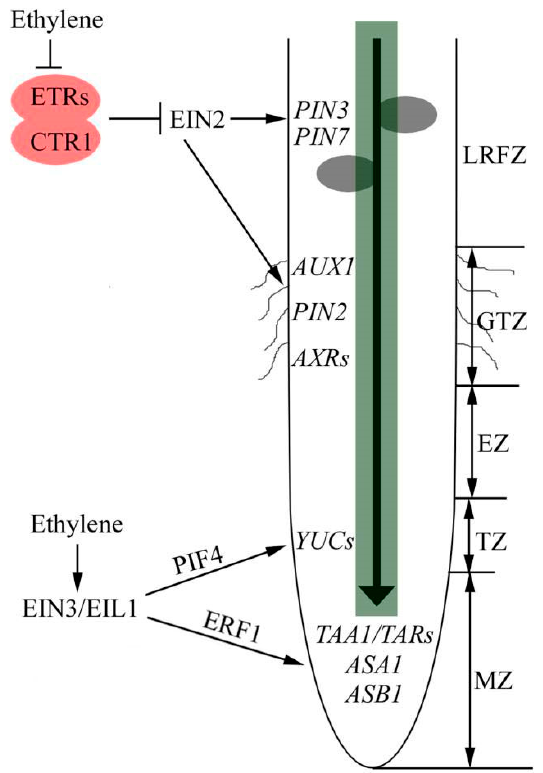
Figure 1. Ethylene directs auxin to control root growth. The growth zones in root apex, including meristematic zone (MZ), transition zone (TZ), elongation zone (EZ) and growth terminating zone (GTZ). Ethylene promotes auxin biosynthesis in MZ and TZ through ASA1 , ASB1 , TAA1/TARs and YUCs , leading to inhibition of primary root elongation. ERF1 and PIF4 function as crosstalk nodes between ethylene and auxin in this process. In GTZ, ethylene promotes root hair initiation through modulation of the auxin levels mediated by auxin transporters. In the lateral root-forming zone (LRFZ), ethylene increases rootward auxin transport by increasing transcription and translation of PIN3 and PIN7 in the central cylinder, which prevent the localized accumulation of auxin needed to drive lateral root formation. Arrows indicates positive regulation, T sharp symbol indicates negative regulation, and waves in GTZ zone represent root hairs.